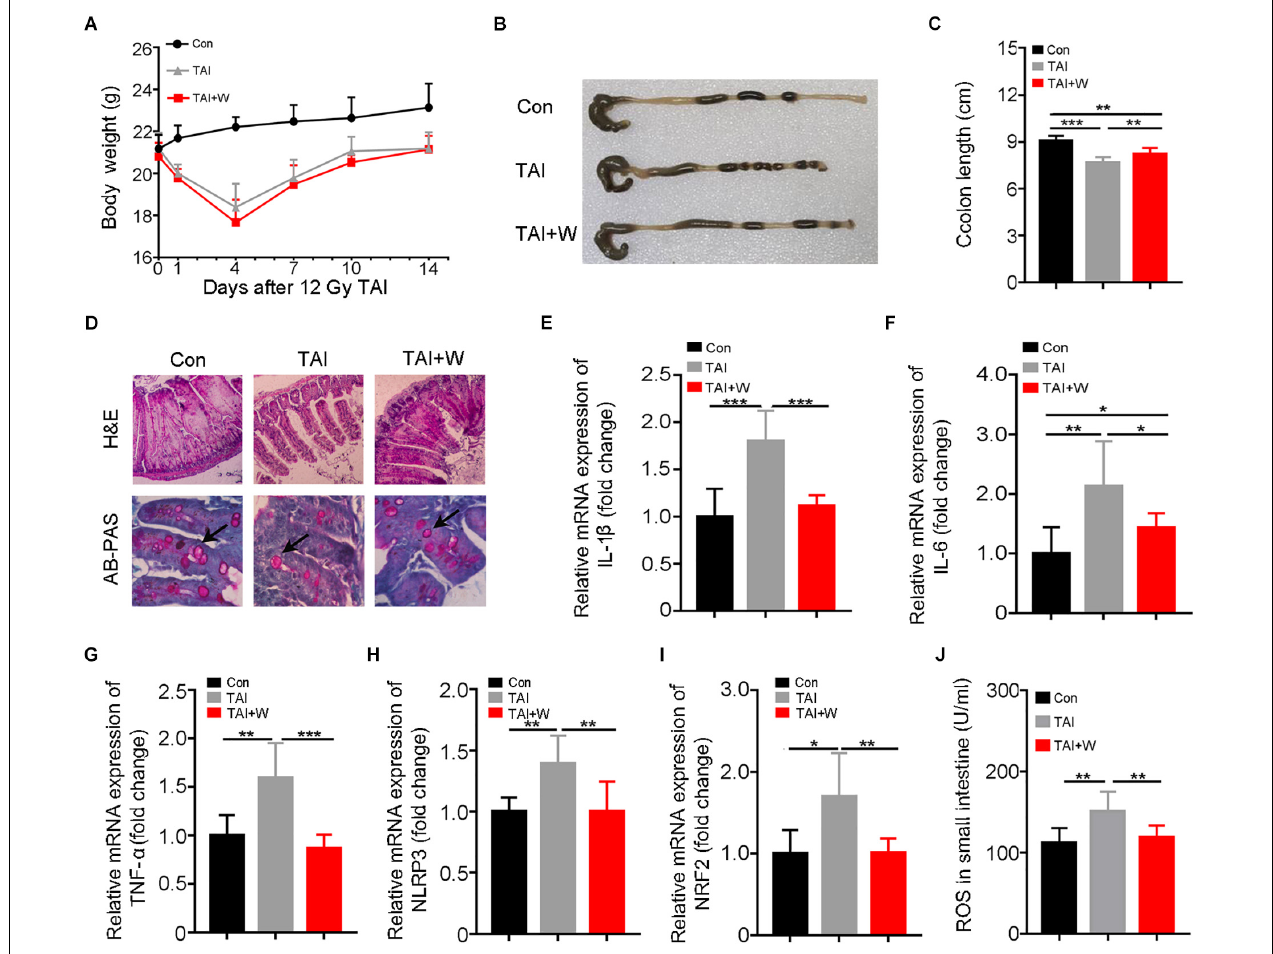
FIGURE 1 | Walking as a non-pharmacological regimen alleviates radiation-induced GI tract injuries in male mice. Male mice were exposed to 12 Gy of TAI, and TAI + W group maintained walking for 15 days, and TAI group had no treatment. Then the colon and small intestine tissues were obtained at day 16, n = 10 per group. (A) The body weight of male mice in the three groups. (B) Photographs of dissected colon from male mice in the three groups. (C) Statistical results of colon length between two groups. (D) The morphology of the small intestine from male mice in the three groups is shown by H&E and PAS staining. The black arrows point to the goblet cells. (E–I) The expression levels of IL-1 β , IL-6 , TNF- α , NLRP3 , and NRF2 were examined in small intestine tissues from male mice by qRT-PCR. (J) The levels of ROS in the small intestine of male mice were measured by ELISA. Significant differences are indicated: * p < 0.05, ** p < 0.01, and *** p < 0.005